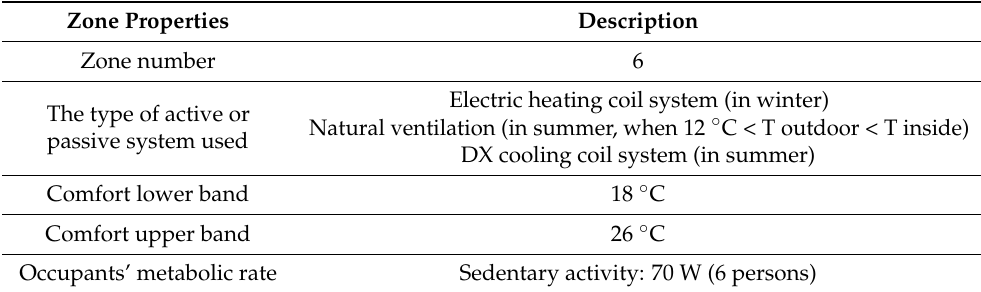
Table 2. Zone properties of the tubular house